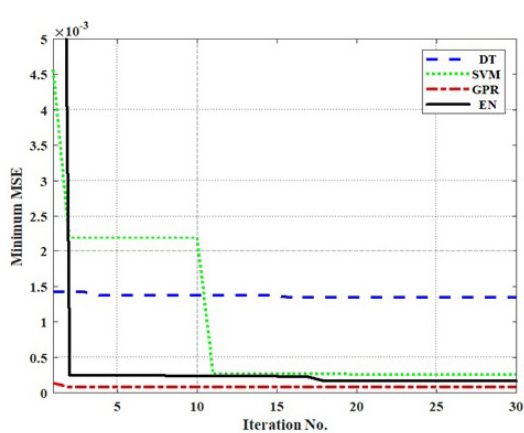
Figure 4. Minimum MSE of DT, SVM, GPR, and EN methods against iteration numbers through the optimization process in the training stage.